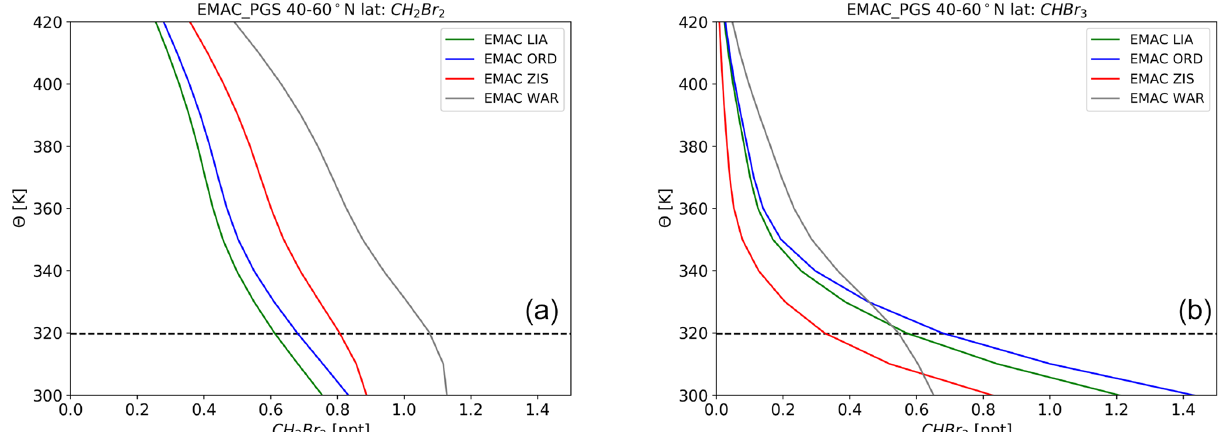
Figure 8. Vertical profiles of CH 2 Br 2 (a) and CHBr 3 (b) averaged over 40–60 ◦ latitude from four model simulations with the EMAC model using the emission scenarios by Liang et al. (2010), Warwick et al. (2006), Ordóñez et al. (2012) and Ziska et al. (2013). The data have been averaged for the period from January to March, i.e. representative of the time period covered by the PGS campaign. The dashed line represents the model tropopause. Model results are nudged simulations of EMAC but do not cover the time period of our